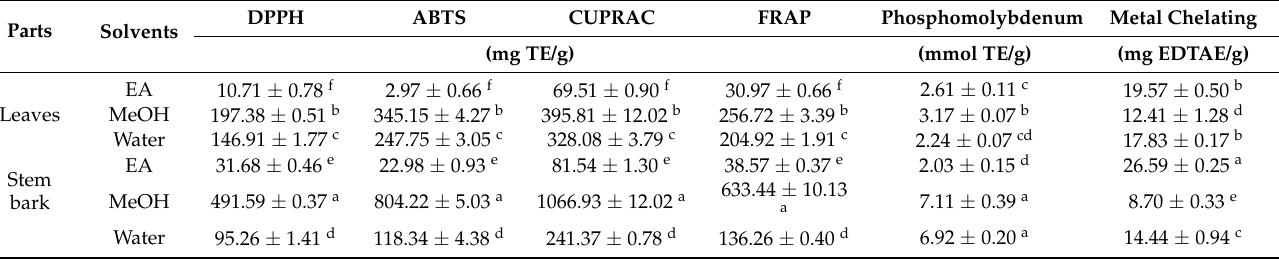
Table 3. Antioxidant properties of the tested